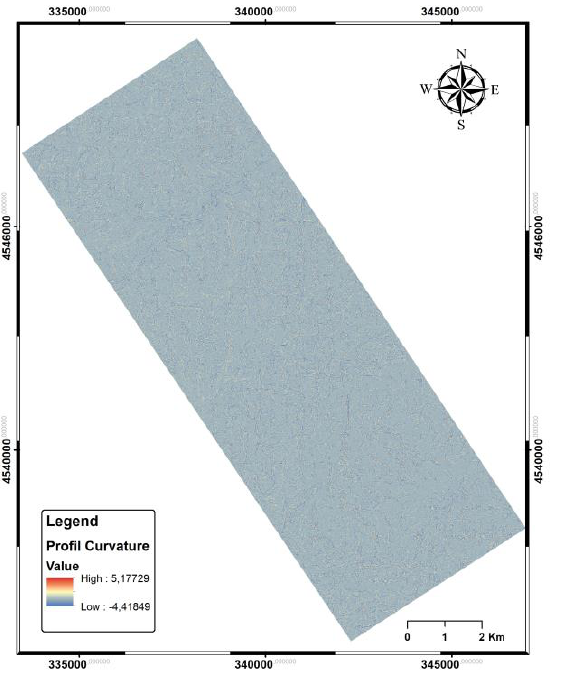
Figure 11. Distance to drainage network map of the study